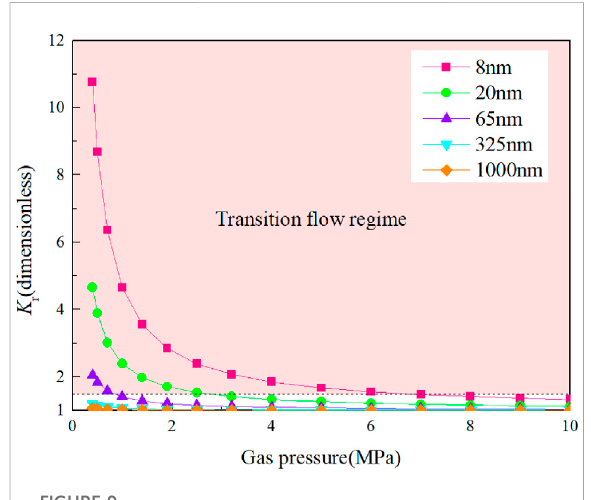
FIGURE 9 Variation in the dimensionless permeability coef fi cient with pressure for different pore sizes.